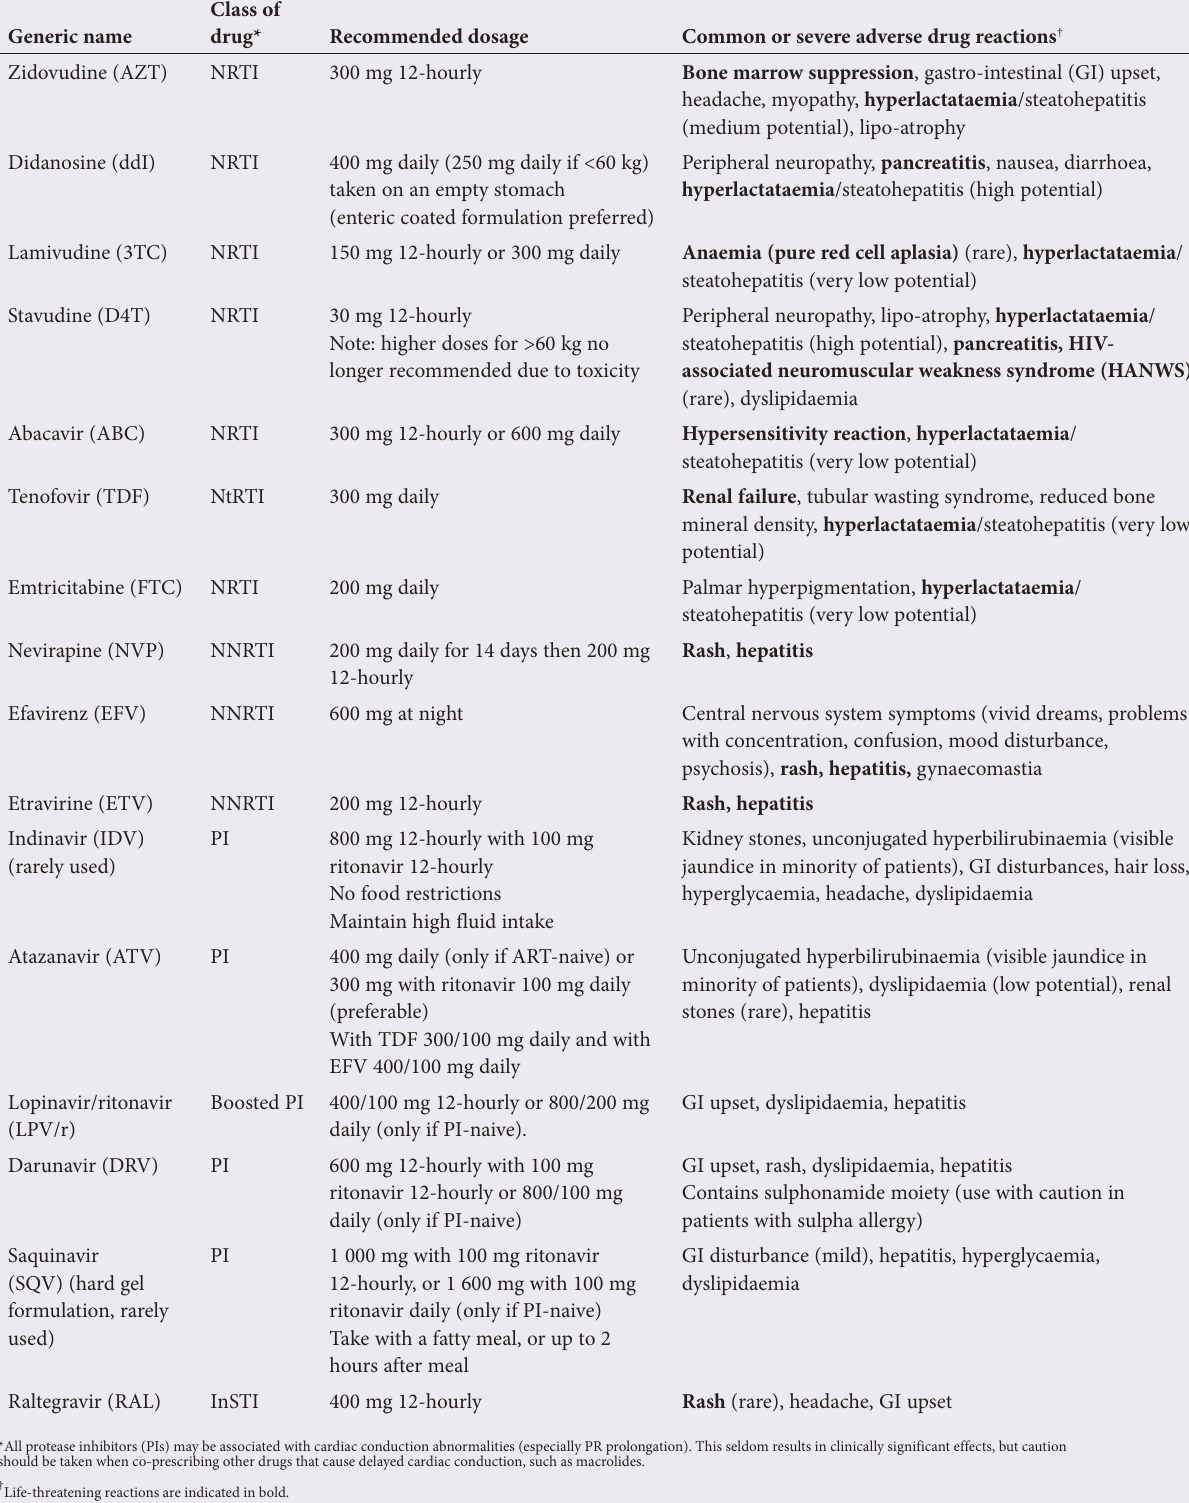
Table 2. Dose and common adverse drug reactions of ARV agents available in Southern Africa Generic